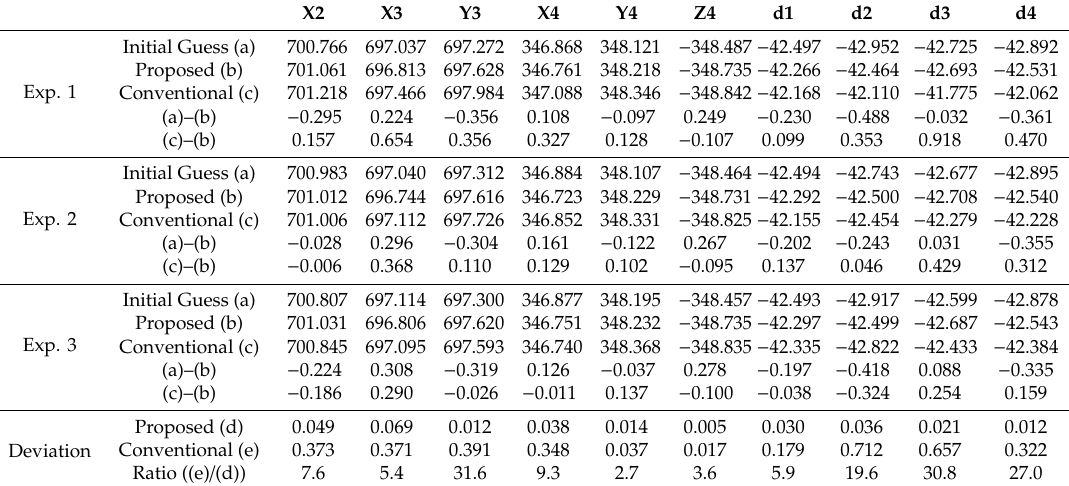
Table 1. Estimation results of system parameters by using proposed and conventional self-calibration methods (unit: mm).